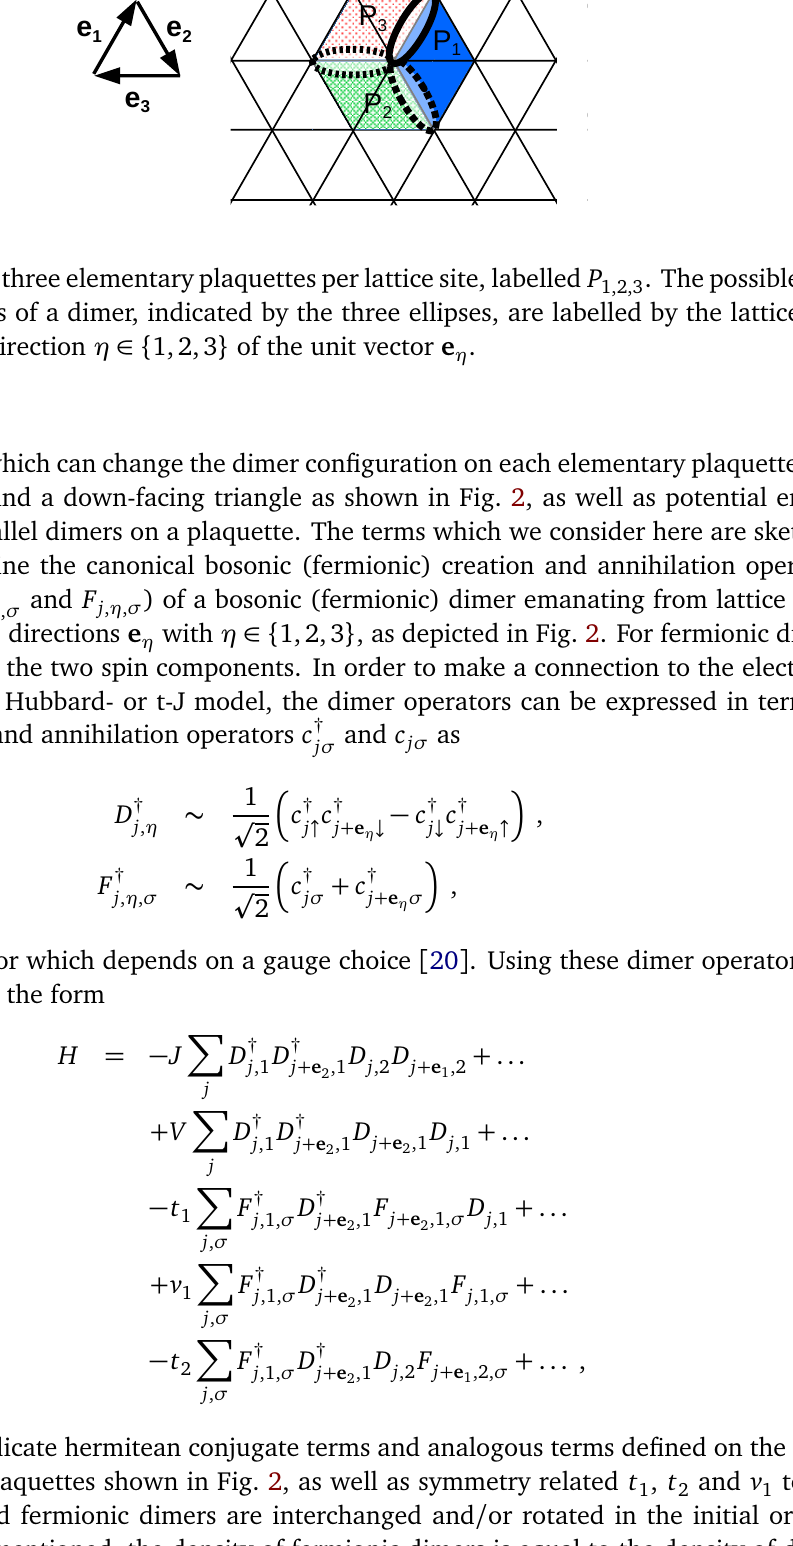
. The possible 1,2,3